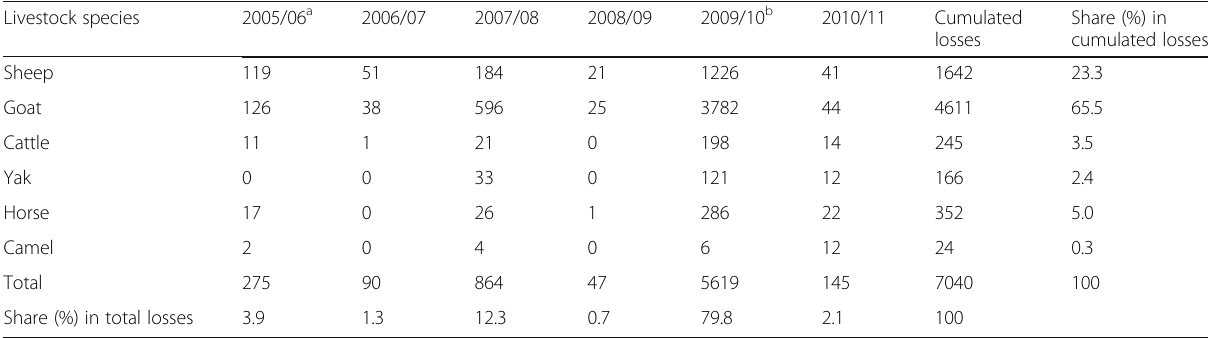
Table 2 Annual livestock losses (head) from 2005 to 2011 as recalled by 50 interviewed herder households in the Bayan-Ölgii and Khovd provinces (Mongolian Altai) Livestock